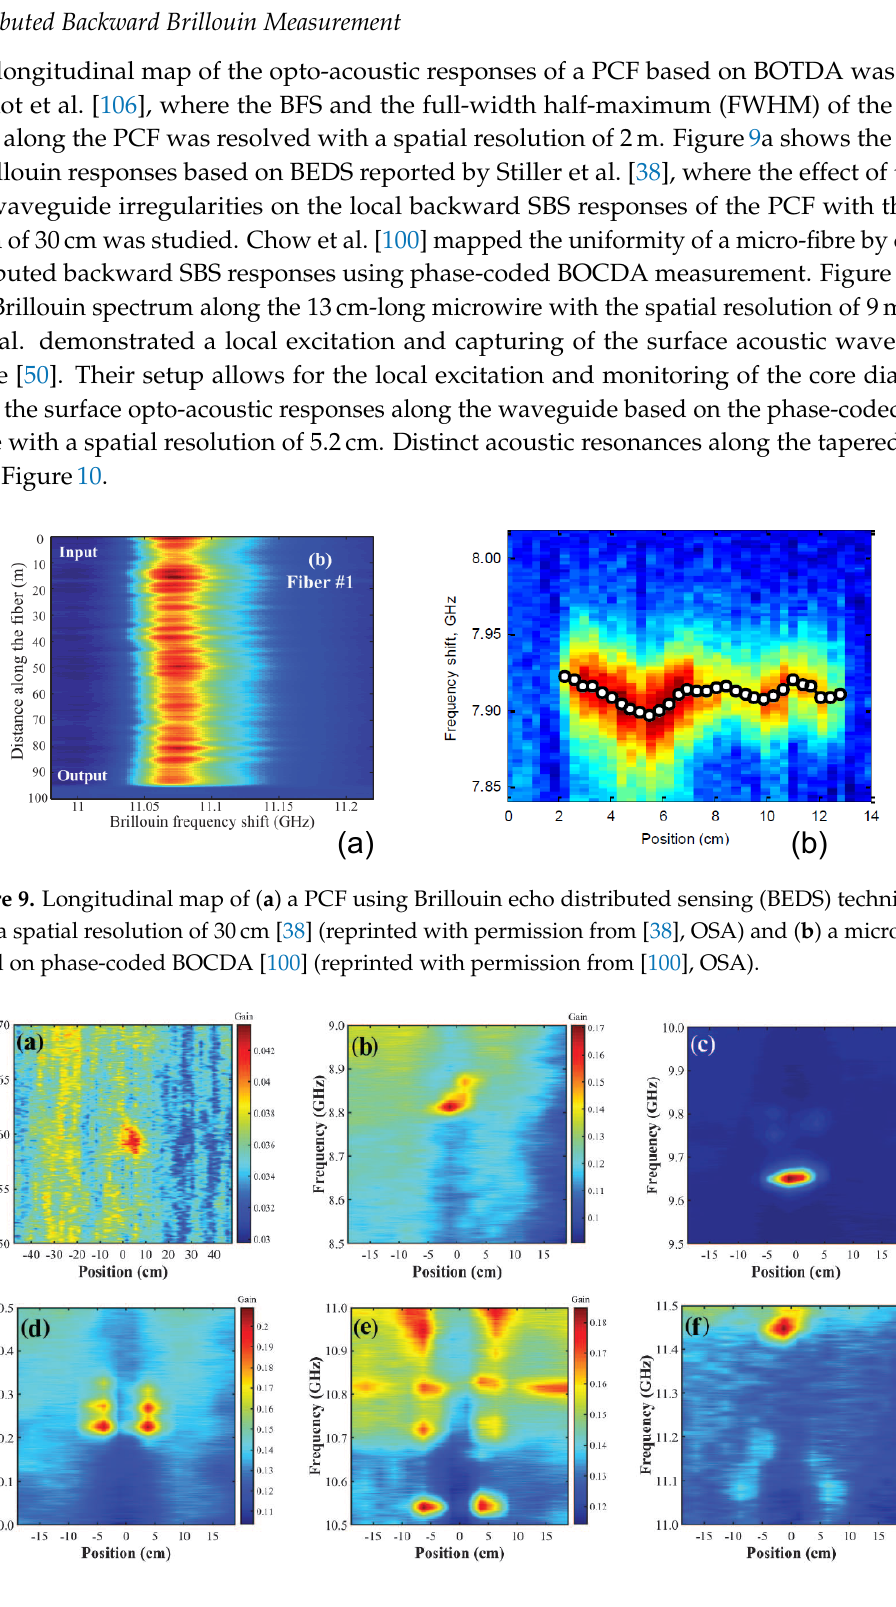
Figure 10. Brillouin spectrum of the tapered fibre using phase-coded BOCDA measurement at different frequency ranges ( a – f ) [50] (reprinted with permission from [50],